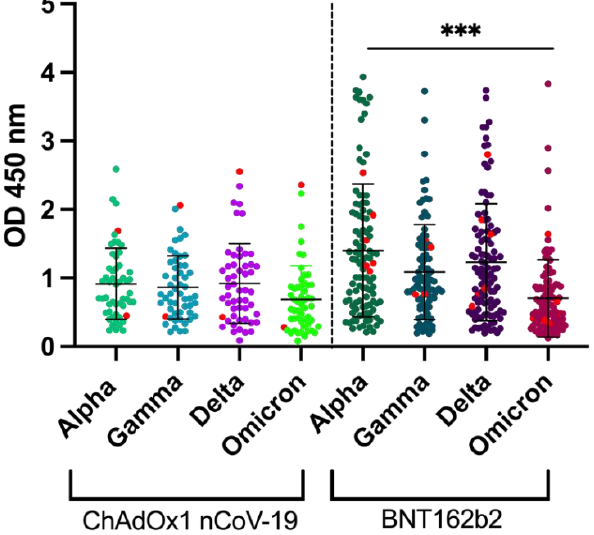
Figure 4. Intervariant differences of RBD-specific IgG of ChAdOx1 nCoV-19 (Oxford/AstraZeneca) recipients compared with BNT162b2 (Pfizer). Individuals who tested positive in the nucleocapsid ELISA and were classified as convalescent are marked in bright red. ( *** p < 0.001